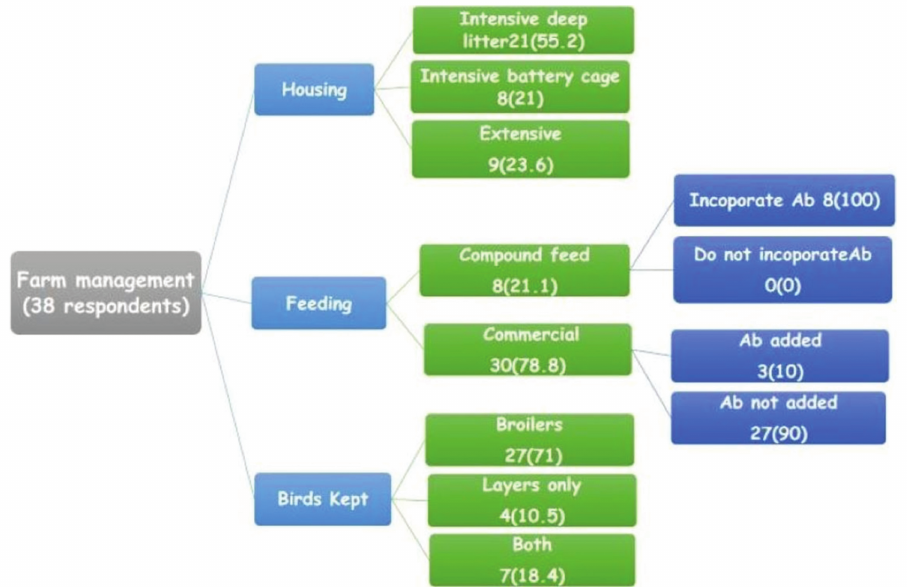
Figure-2: Poultry farm management practices in the two major cities (Nsukka and Enugu) of the two agricultural zones. Table-1: Gentamicin drug use by farms in Nsukka and Enugu metropolis, Enugu state, Southeast Nigeria.